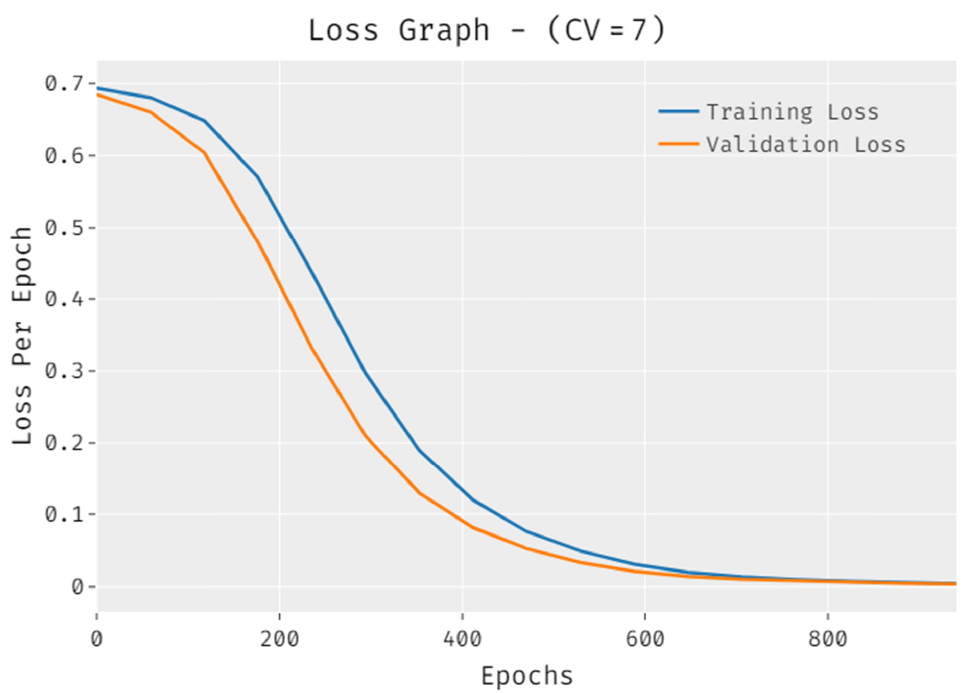
Figure 8. Loss analysis of IDLDMS-PTC technique under CV of 7.